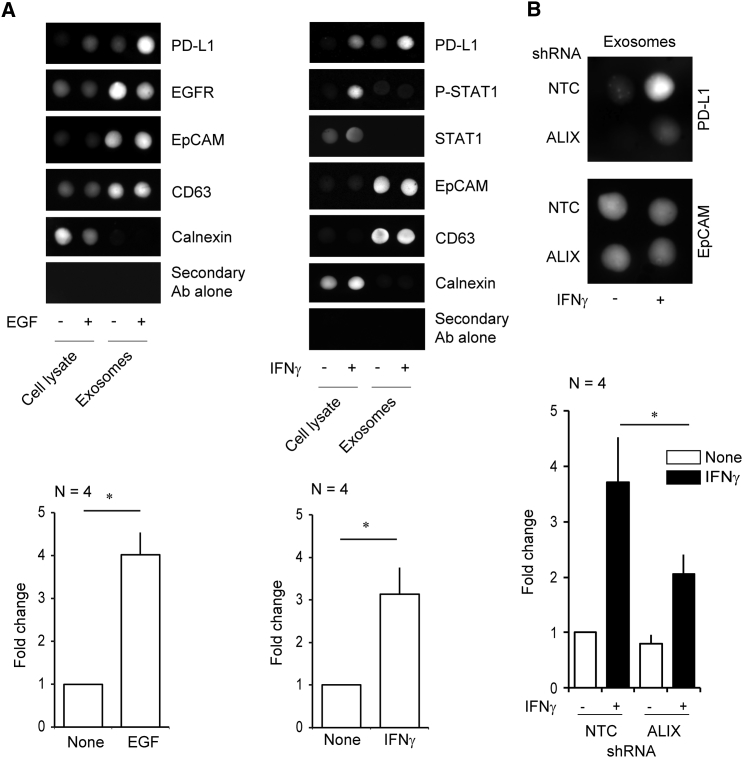
Ligand-Induced Expression and Exosomal Packaging of PD-L1 in HCC1954 Breast Cancer Cells(A and B) Dot-blots (1 μg per spot) and associated densitometry analysis showing the EGF- and/or IFNγ-dependent induction of PD-L1 protein expression and exosomal packaging in HCC1954 cells (mean fold change ± SEM; ∗p < 0.05, two-tailed Student’s t test) (A). (B) IFNγ-dependent induction of PD-L1 protein expression and exosomal packaging in NTC or ALIX KD equivalent cell lines.See also Figure S4.